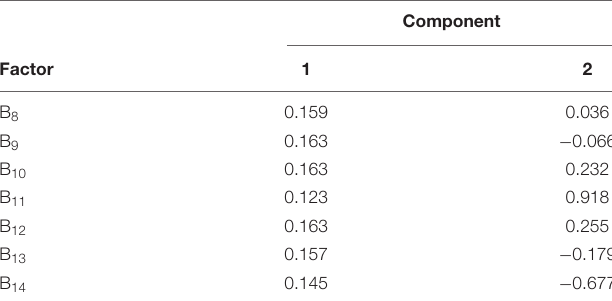
TABLE 10 | Component score coefficient matrix.